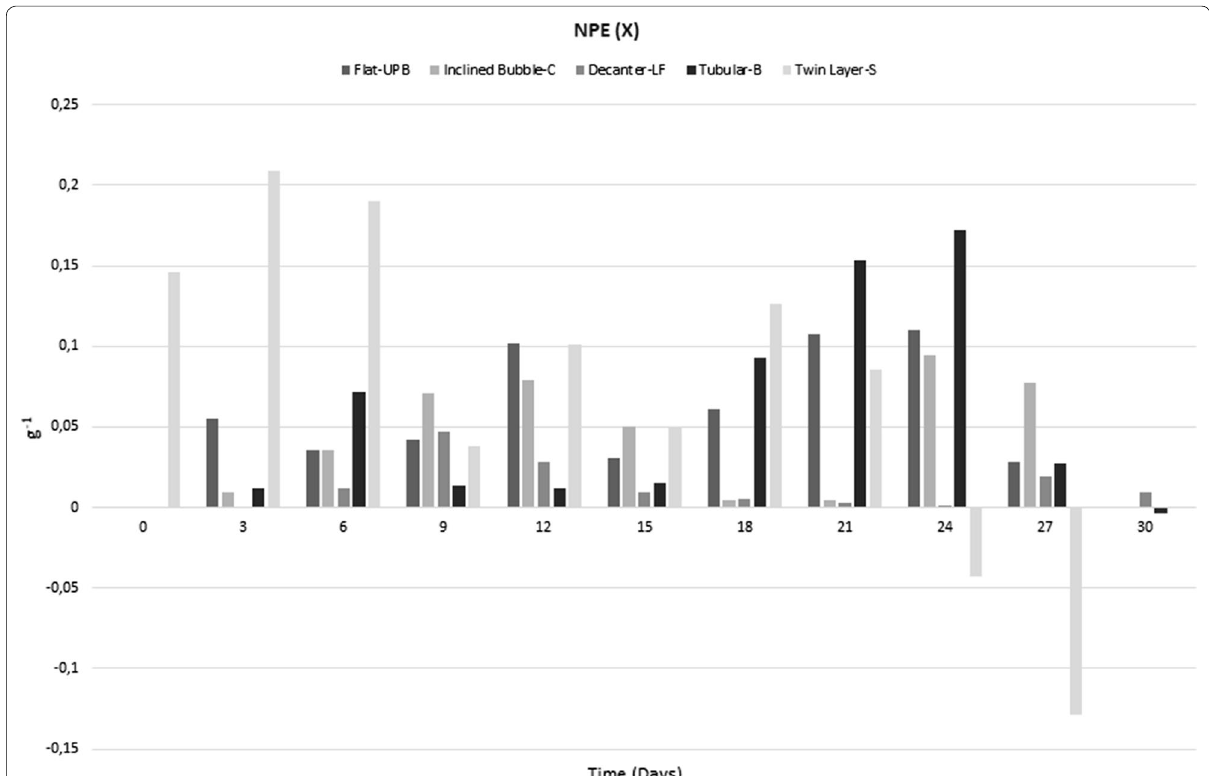
Fig. 6 Normalized photosynthesis efficiency (NPE) in different photobioreactors during 30th